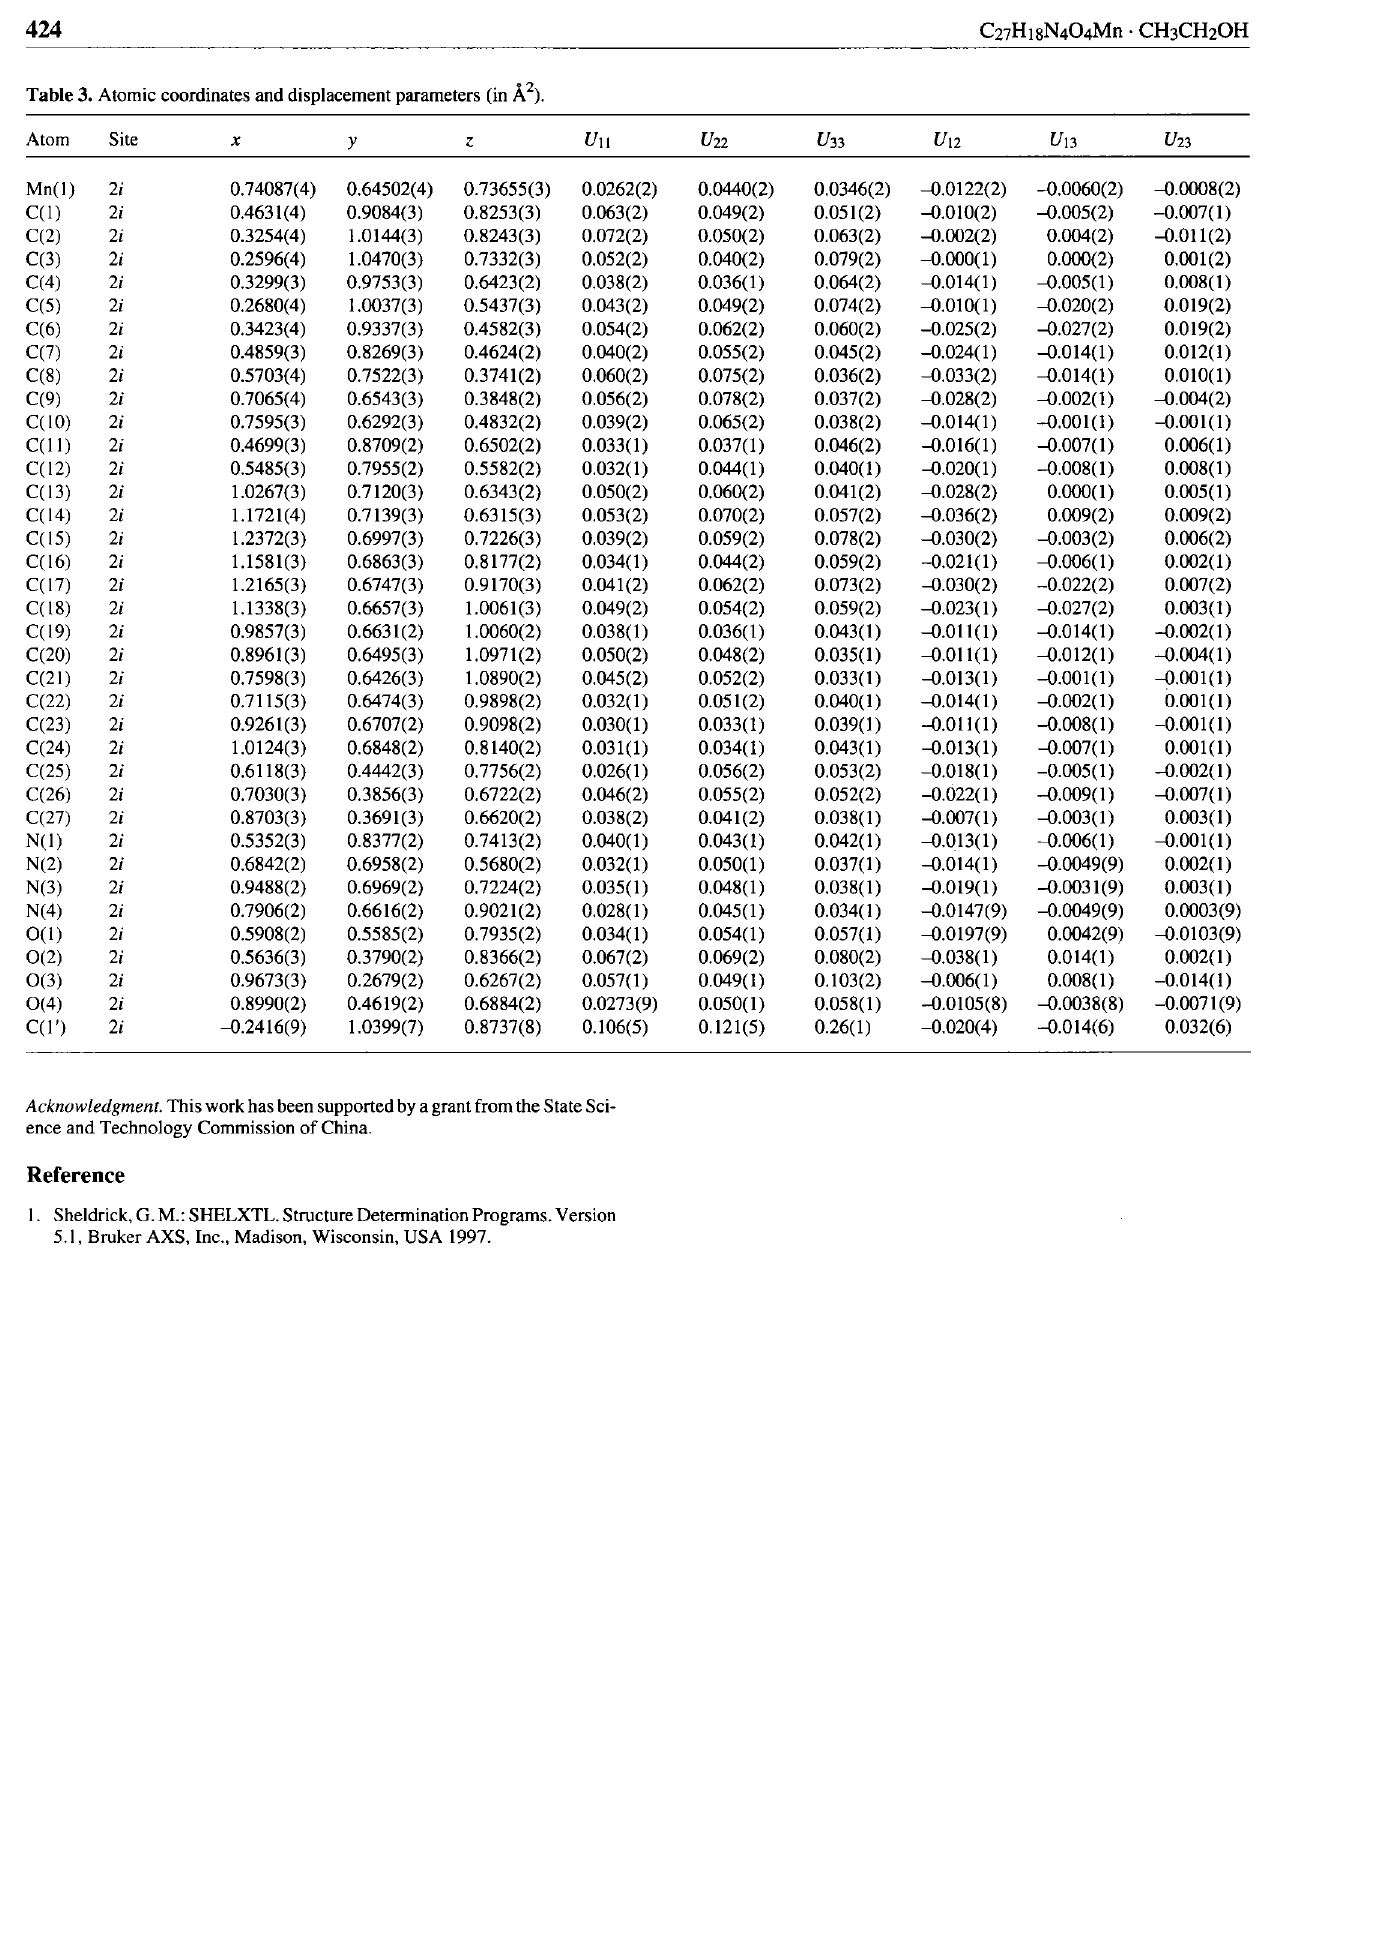
Table 3. Atomic coordinates and displacement parameters (in Ä 2